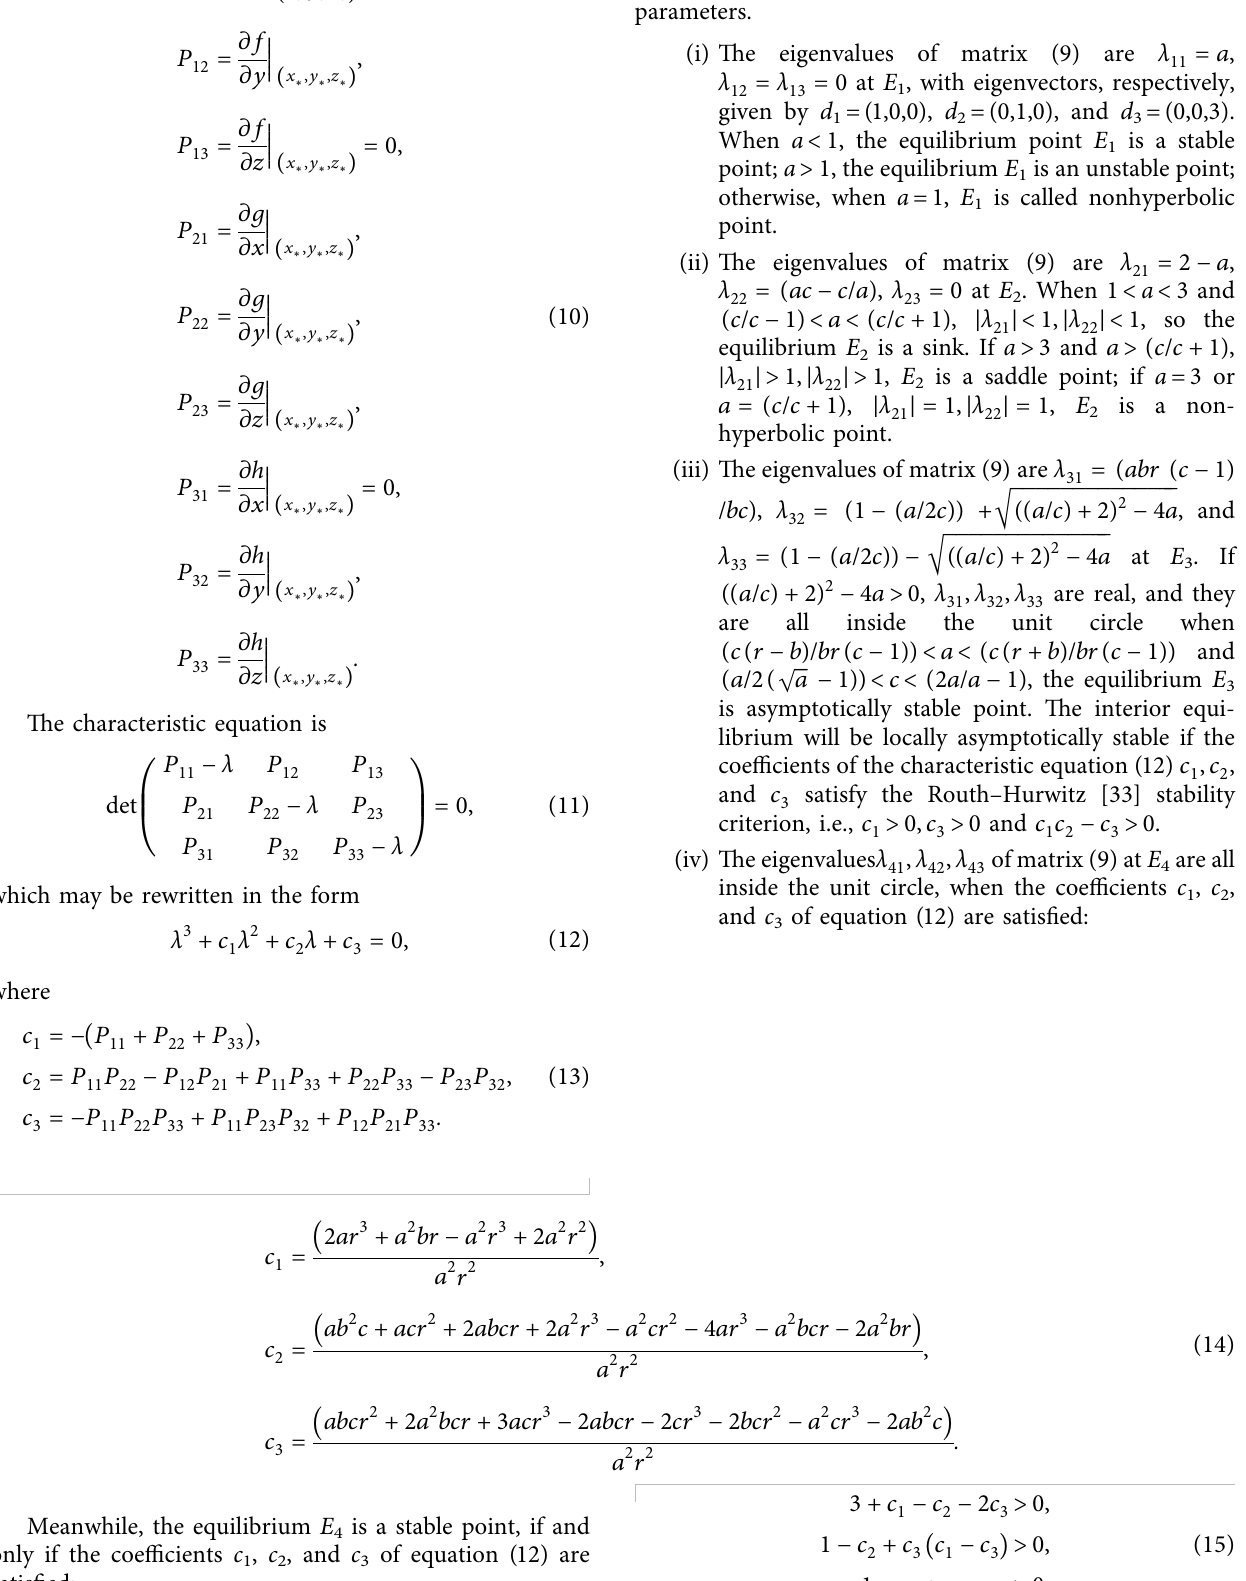
There exist different topological types of ( x , y , z ) , ( i � 1 , 2 , 3 , 4 ) for all permissible values E i ∗ ∗ ∗